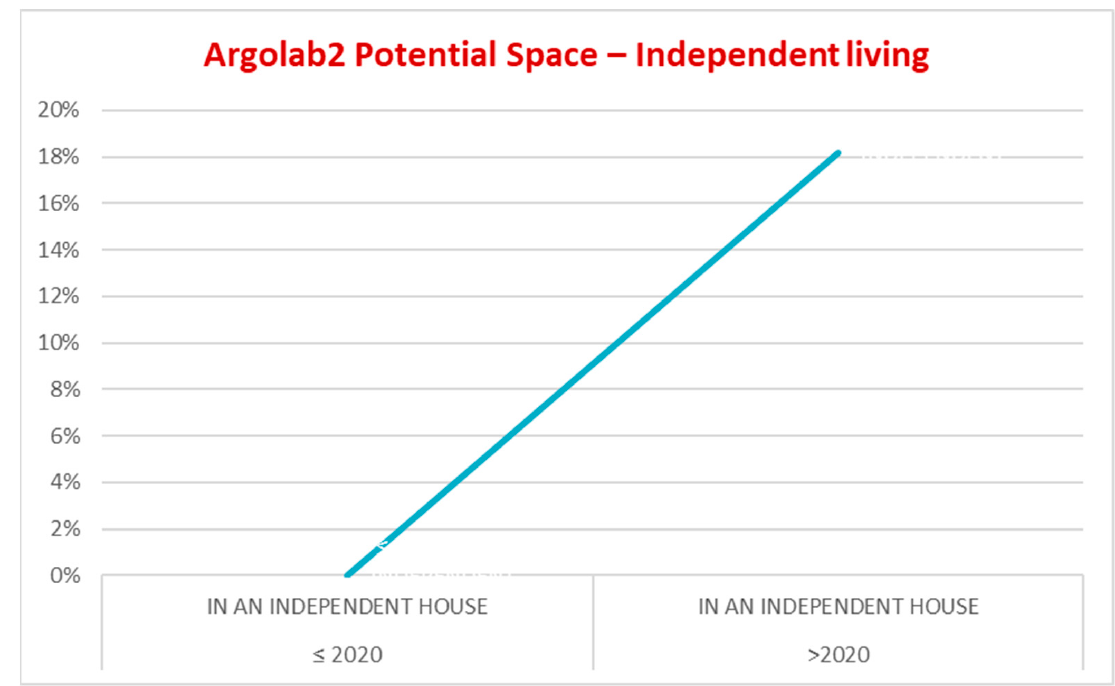
Figure 6. “Argolab2 Potential Space” —Independent living.